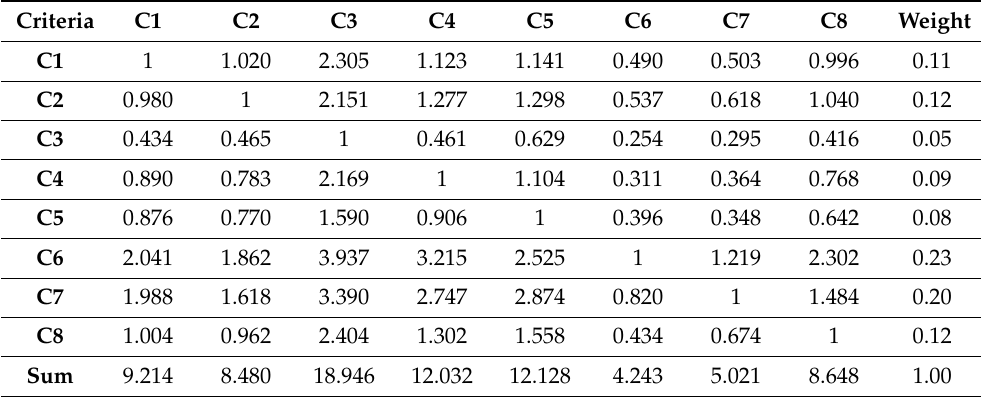
Table 8. Pairwise comparison matrix for residential land use suitability using the geometric mean of the preferences with the computed weights.